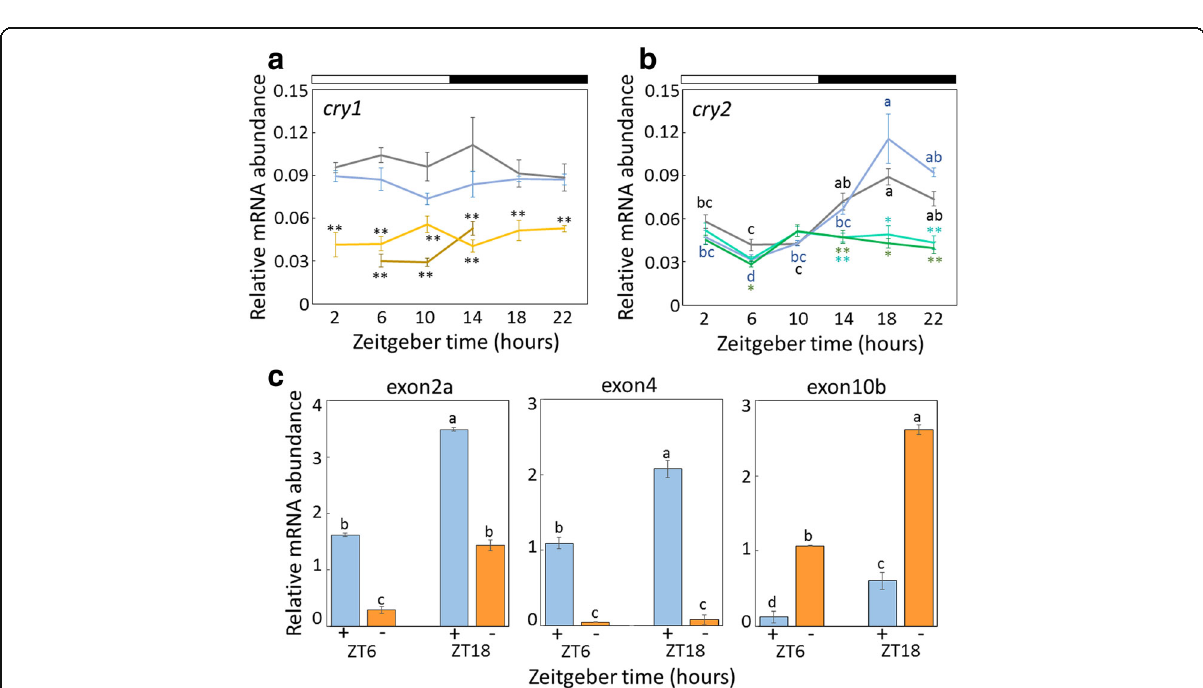
Fig. 2 Expression profiles of Gb ’ cry1 ( a ) and Gb ’ cry2 mRNA ( b , c ) in Gryllus bimaculatus optic lobes under LD 12:12. In ( a ) and ( b ), abundance of Gb ’ cry1 and Gb ’ cry2 mRNA is shown for intact ( blue ), ds DsRed2 ( gray ), ds Gb ’ cry1#d1 ( yellow ), ds Gb ’ cry1#d2 ( dark yellow ), ds Gb ’ cry2#d1 ( dark green ), ds Gb ’ cry2#d2 ( green ) treated crickets. Total RNA was extracted from the optic lobes that were collected at 4-hour intervals starting at 2 h after lights-on (ZT 2). White and black bars indicate light and dark , respectively. Gb ’ cry1 was rather constitutively expressed. Gb ’ cry2 showed rhythmic expression in intact and DsRed2 RNAi crickets (cosinor, P < 0.01), while the rhythm disappeared when treated with ds Gb ’ cry2 (cosinor, P > 0.05). Note that dsRNA significantly reduced mRNA levels of respective genes, while DsRed2 dsRNA had no significant effect. Asterisks indicate significant difference between control ( DsRed2 RNAi ) and treated crickets (* P < 0.05, ** P < 0.01, Dunnett ’ s test). c Semi-quantification of Gb ’ cry2 mRNA levels at ZT6 and ZT18 with ( blue ) and without ( orange ) exon 2a, 4, or 10b. Different lower case letters indicate that values are significantly different with each other (ANOVA followed by Tukey-test, P < 0.05). For ( a – c ), data collected from three or five independent experiments were averaged and plotted as mean ± SEM. The abundance of Gb ’ rpl18a mRNA was used as an internal